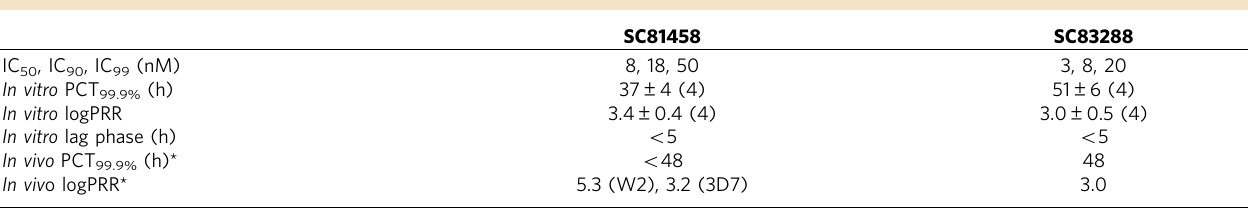
Figure 2 | Structure-activity relationship (SAR) analysis. ( a ) Antiplasmodial activity of 172 chronologically ordered amicarbalide derivatives against the P. falciparum strain Dd2. Substitutions on the West-side amidine group (grey), the benzamidine urea linker (green) and the East-side sulfonamide group (dark blue and red) are indicated. The two compounds SC81458 and SC83288 are highlighted. ( b ) Summary of the SAR analysis. Colour code as above. Table 1 | Relevant activity parameters of SC81458 and SC83288.